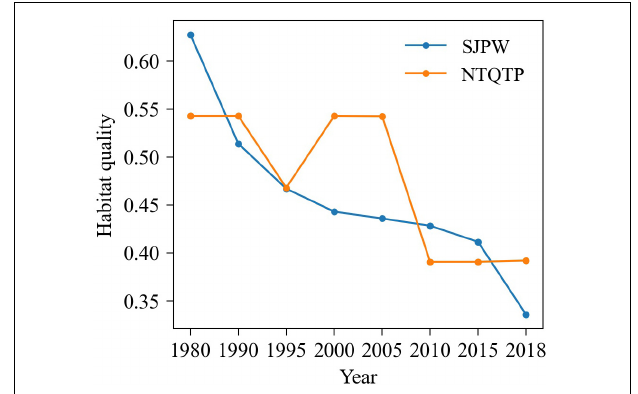
FIGURE 5 | Habitat quality changes in SJPW and NTQTP from